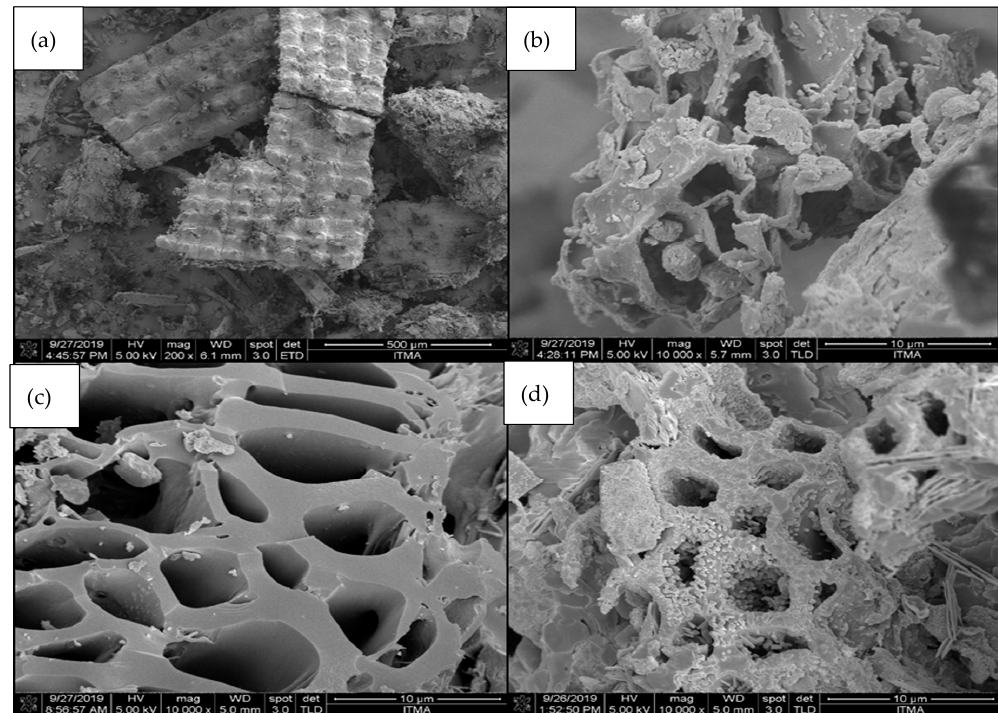
Figure 4. Field emission scanning electron microscopy (FESEM) image; ( a ) External surface RH (200 × ), ( b ) Cross-section view of RHC (10,000 × ), ( c ) RHC (10,000 × ), ( d ) Nano-magnetic RHC/K2O-20%/Fe-5% catalyst (10,000 × ).